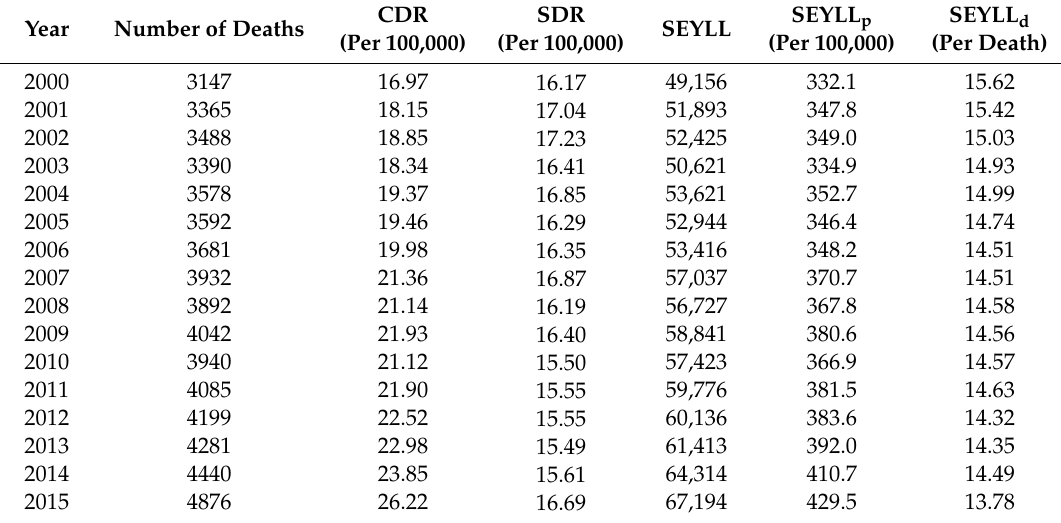
Table 1. Number of deaths and values of CDR, SDR, SEYLL, SEYLL p and SEYLL d due to prostate cancer in Poland in 2000–2015.